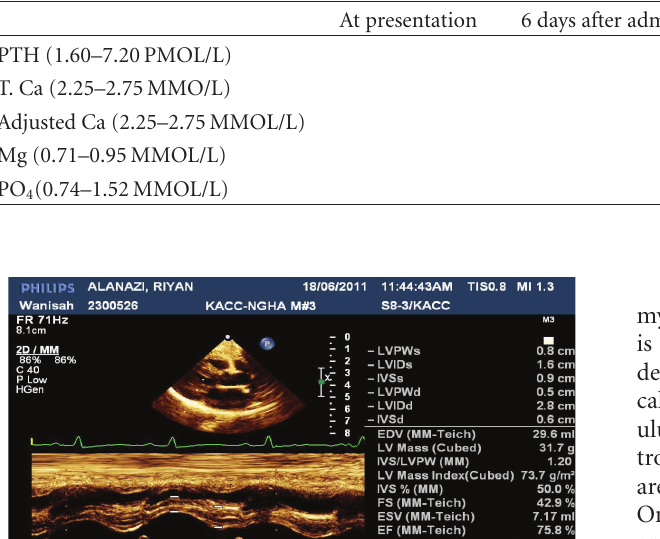
Table 2: Bone profile and parathyroid hormone for the patient on day 6 and 9 after admission and at discharge. At presentation